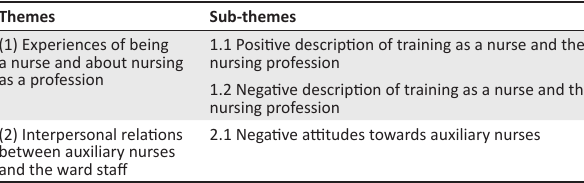
TABLE 2: Themes and sub-themes as experiences of poverty alleviation programme trainees regarding nursing and nursing